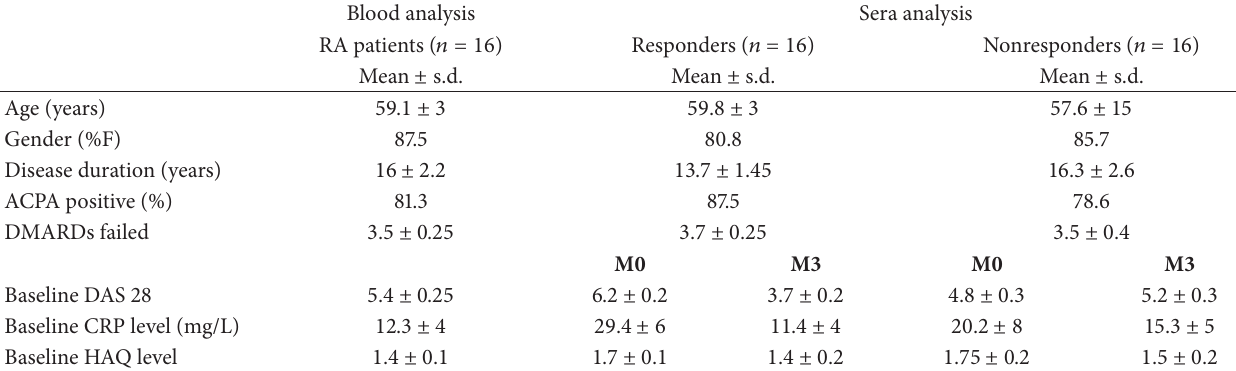
Table 1: RA patient